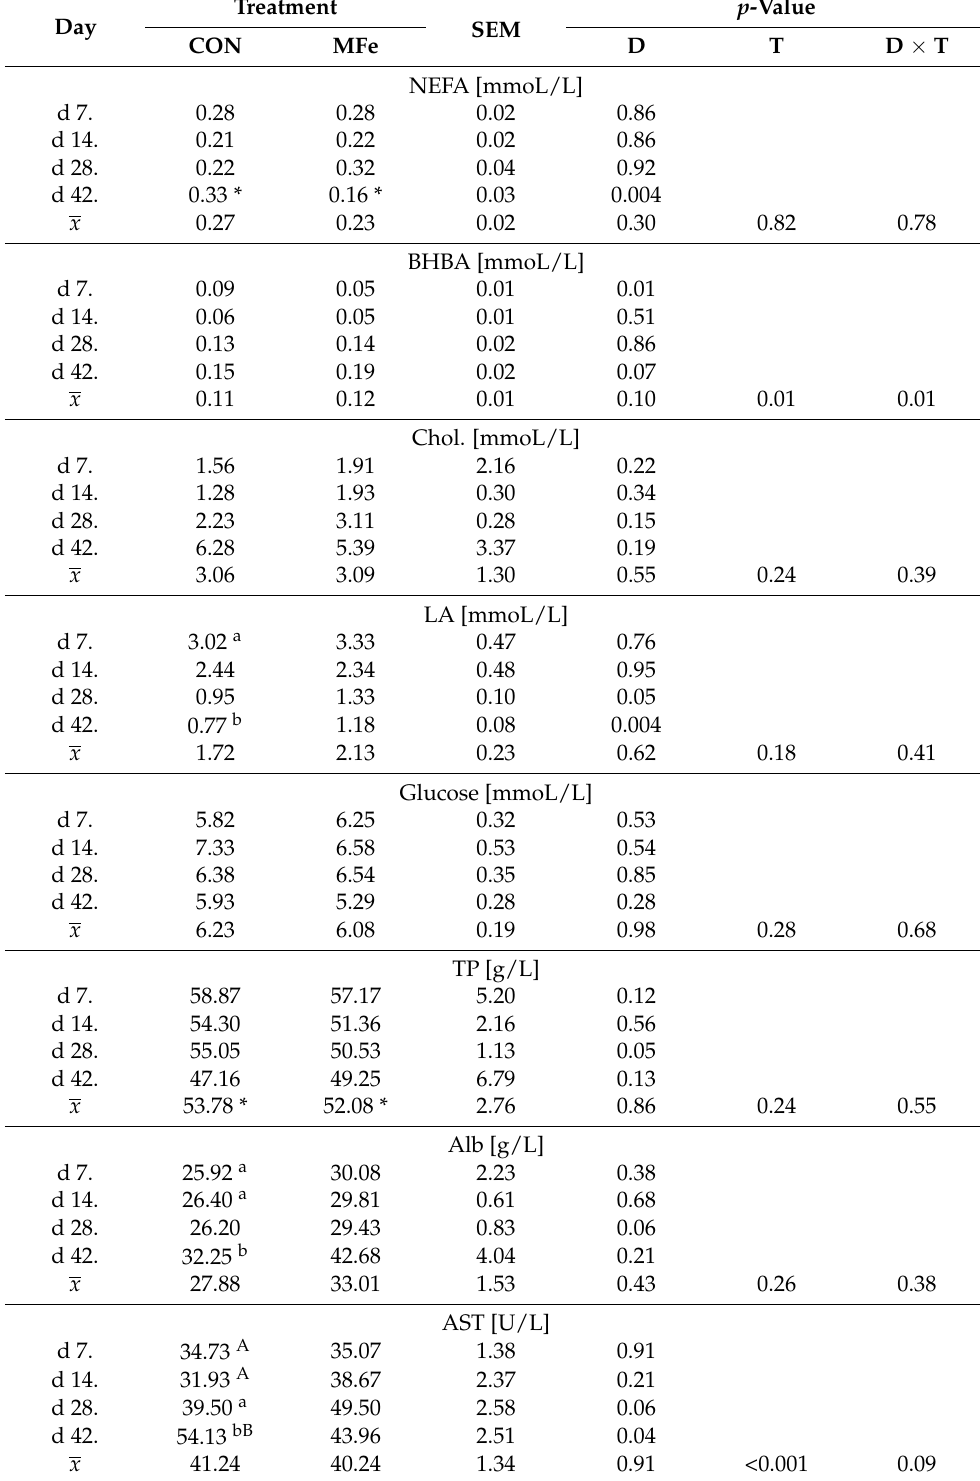
Table 5. Mean values of the selected biochemical in calves’